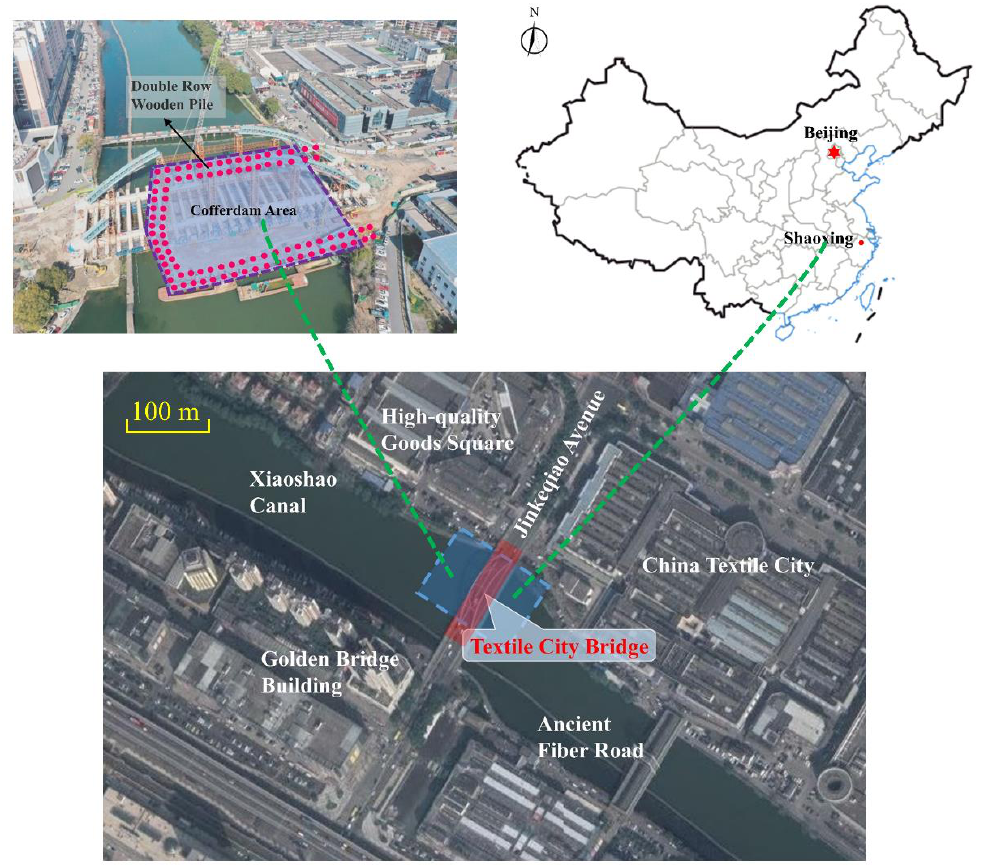
Figure 5. Plan view of the project.